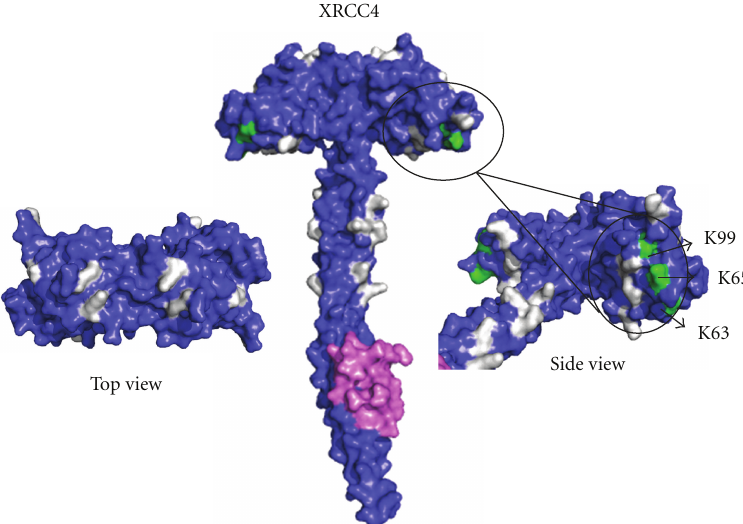
Figure 15: Surface views of XRCC4 1–213 -DNA ligase IV peptide structure (PDB code:1IK9). Residues K63, K65, and K99, which are 748–784 important for XLF-XRCC4 binding are labeled in green. Nonessential residues for XLF-XRCC4 interaction K26, R71, K72, K90, R107, K115, K146, R150, R153, R161, and R164 are labeled in grey [112].